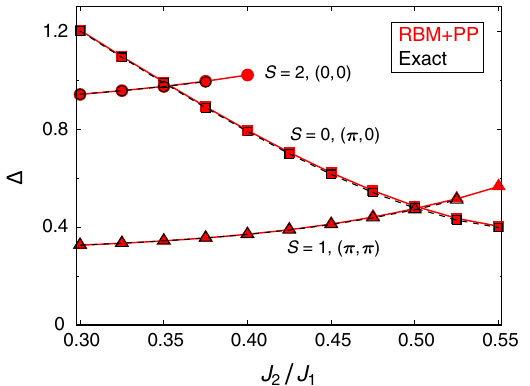
FIG. 11. Singlet, triplet, and quintuplet excitation energies for 6 × 6 lattice obtained by RBM þ PP (filled symbols) and ED (open symbols). In ED, we calculate up to five excited states using H Φ [75]. At J 2 ¼ 0 . 40 , S ¼ 2 excitation with the mo- mentum (0,0) is not included in the five lowest excited states. The same holds for S ¼ 1 excitation with the momentum ð π ; π Þ at J 0 . 55 . The RBM þ PP and exact results show a good 2 ¼ agreement.